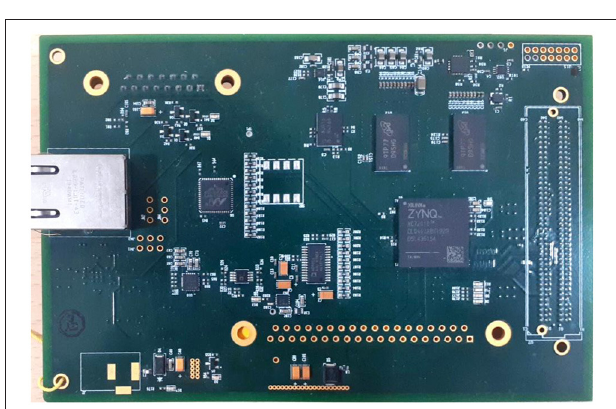
FIGURE 7 | Field-programmable gate array (FPGA) hardware for the proposed